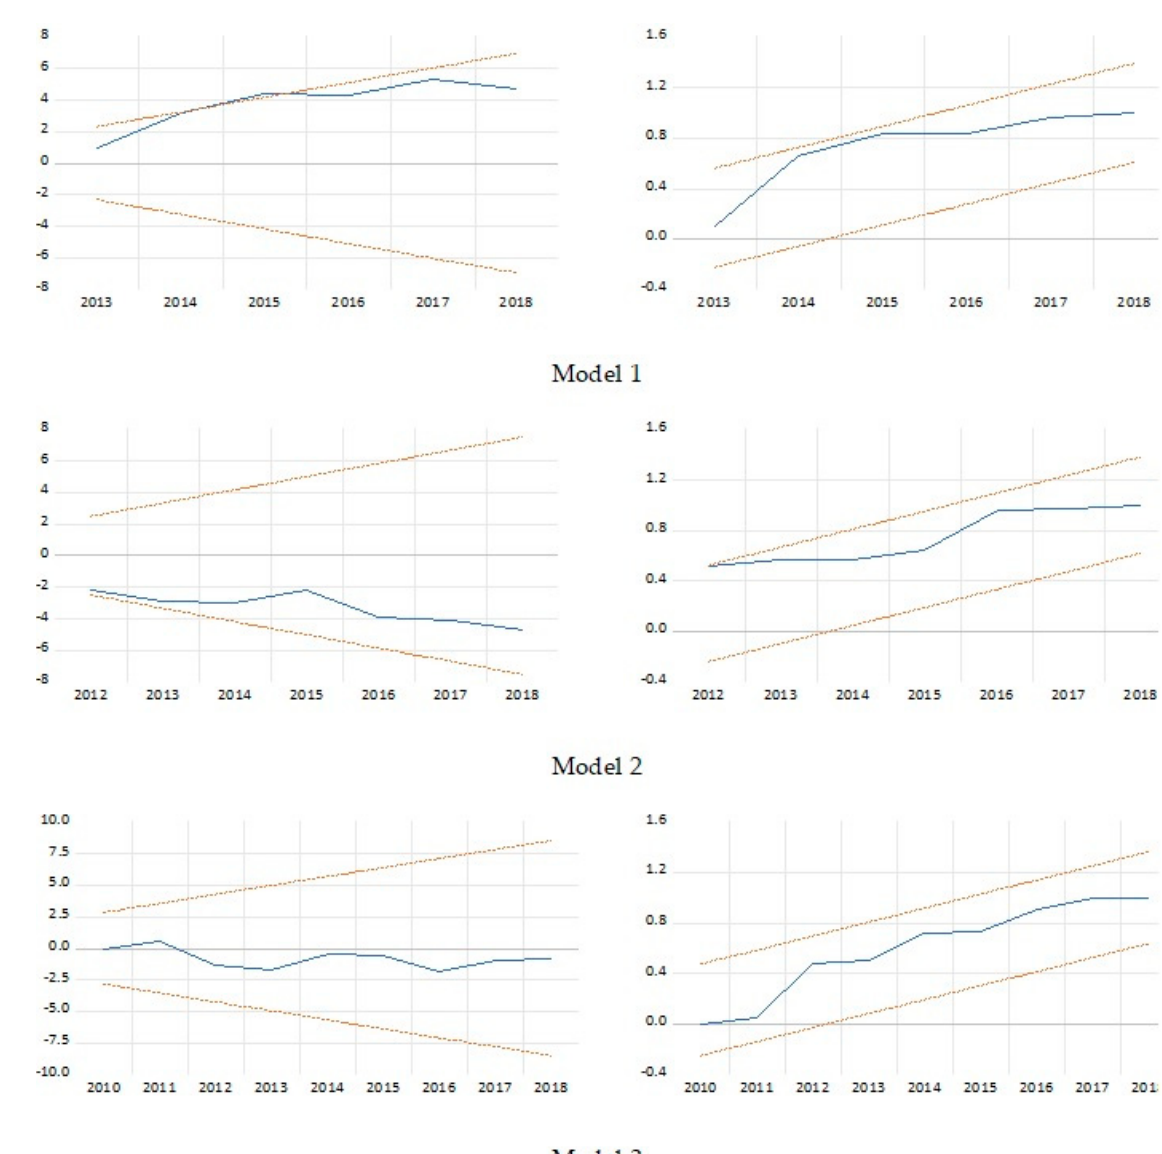
Figure 4. Cumulative sum (CUSUM) and CUSUM square test for stability.